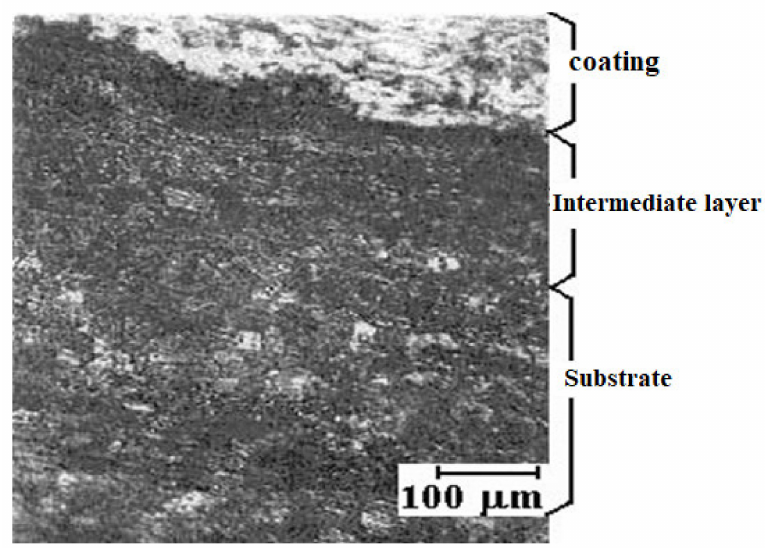
Figure 8. Structure of the coating, intermediate layer, and substrate.